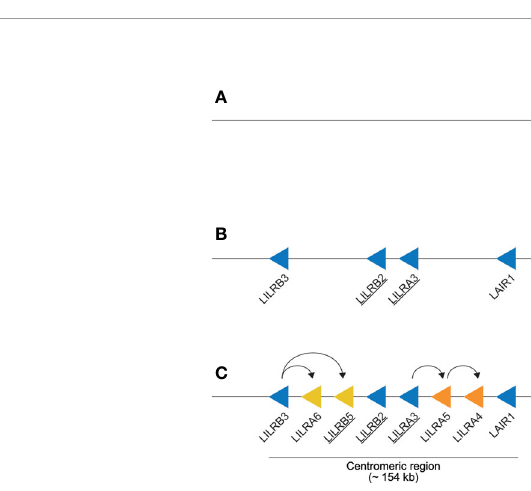
FIGURE 3 | Schematic illustration of the evolution of the human LILR region. (A) As indicated by the curved arrows, the fi rst primitive LILR region arose due to independent LILRA1 duplication events, resulting in the emergence of LAIR2 , LILRB1 , and LILRP1 (depicted by grey arrows). LILRA1 is denoted as the ancestral LILR gene and is therefore depicted by a black arrow. Genes encoding for receptors interacting with HLA epitopes are underlined. (B) The primitive LILR region was subsequently duplicated and reversely incorporated into the genome, shaping the centromeric region containing LILRB3 , LILRB2 , LILRA3 , and LAIR1 , depicted by blue arrows. (C) Next, several independent duplication events occurred in both regions, as indicated by the curved arrows, modeling both a centromeric and a telomeric make-up. Representing the different genes, the arrows are aligned in such a way that they point in the direction of transcription. The colored arrows highlight the different autonomous tandem duplication events. The location of KIR3DX1 gene is indicated (red arrow). The interception with two vertical lines indicates the central